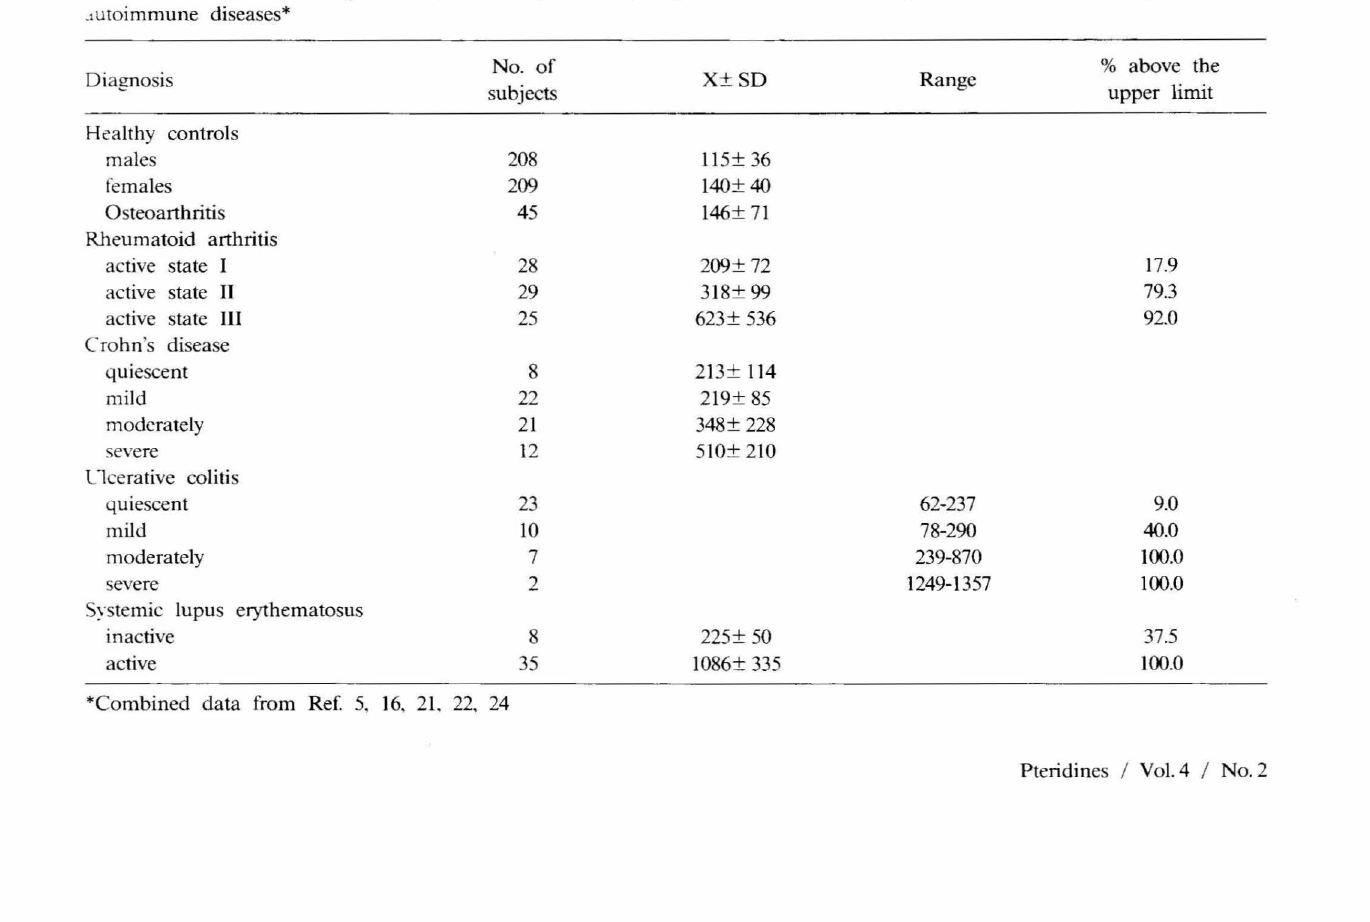
Table 1. Urinal)' neopterin (iJ.mol/mol, creatinine) and frequency of values above the upper limit of tolerance in patients